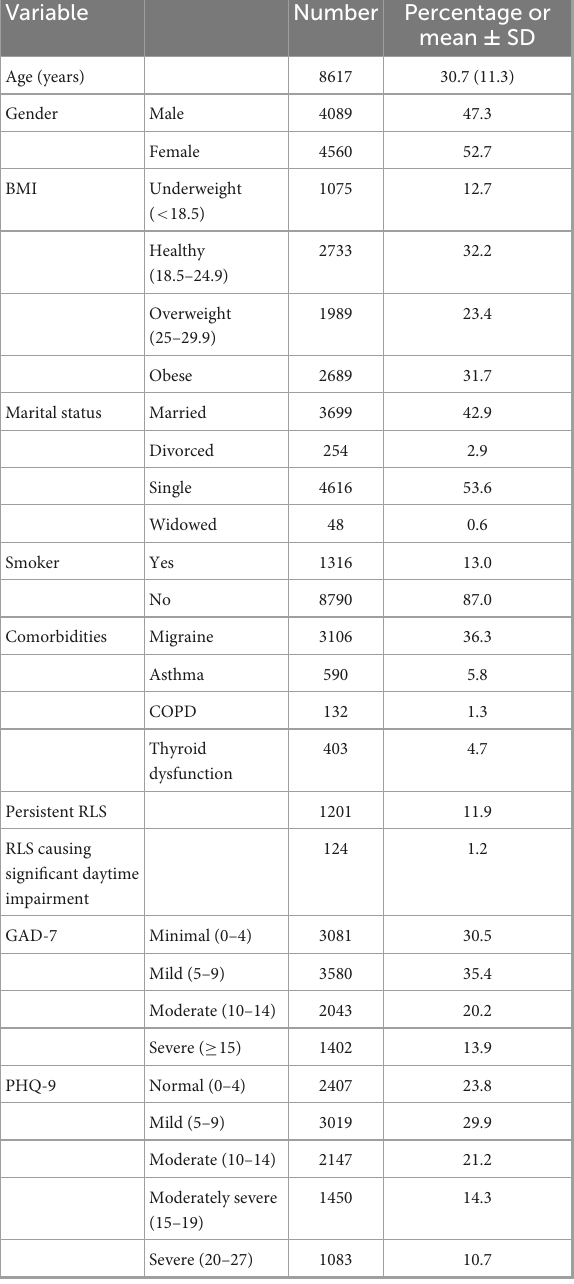
TABLE 1 Demographics of the survey respondents and the prevalence of restless legs syndrome